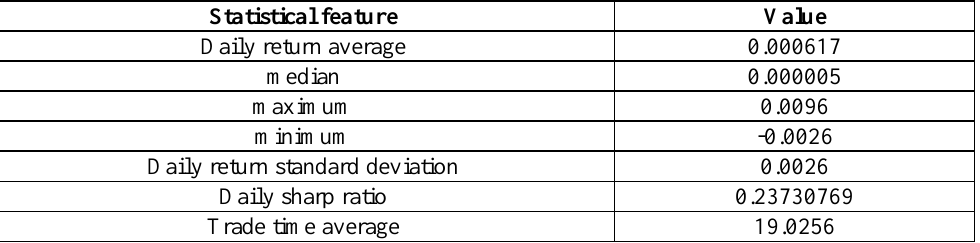
Table 7. Statistical description for the resulted